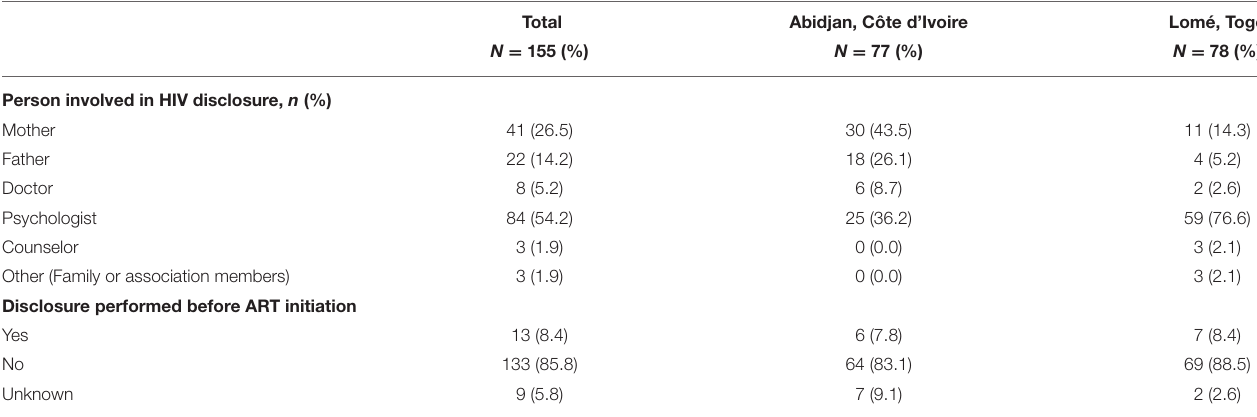
TABLE 5 | Characteristics of the HIV disclosure modalities to the 155 adolescents living with perinatally-acquired HIV disclosed at 24 months by sites in the COHADO cohort, IeDEA-pWADA, 2015–2017. Total Abidjan, Côte d’Ivoire Lomé, Togo N = 155 (%) N = 77 (%) Person involved in HIV disclosure, n (%)